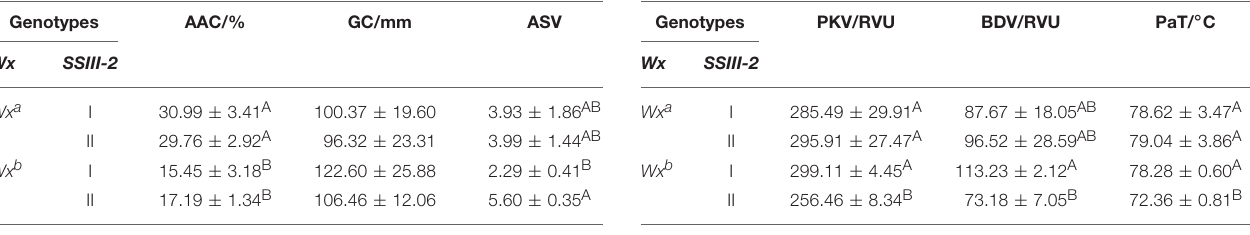
TABLE 2 | Comparison of physicochemical indexes among different combinations of Wx and SSIII-2 alleles. Genotypes